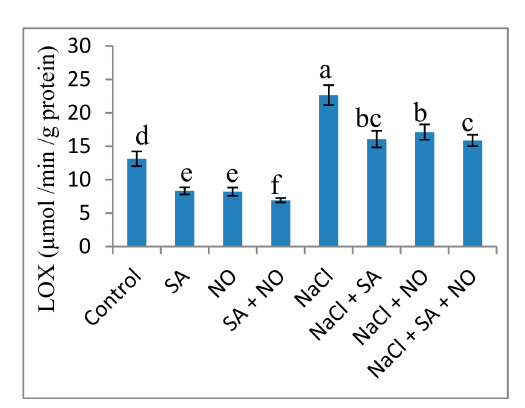
Figure 4. E ff ect of exogenous application of SA and NO on activity of lipoxygenase in Vigna angularis under salinity (100 mM NaCl) stress. Data are the mean of four replicates and di ff erent letters show significant di ff erence at p <